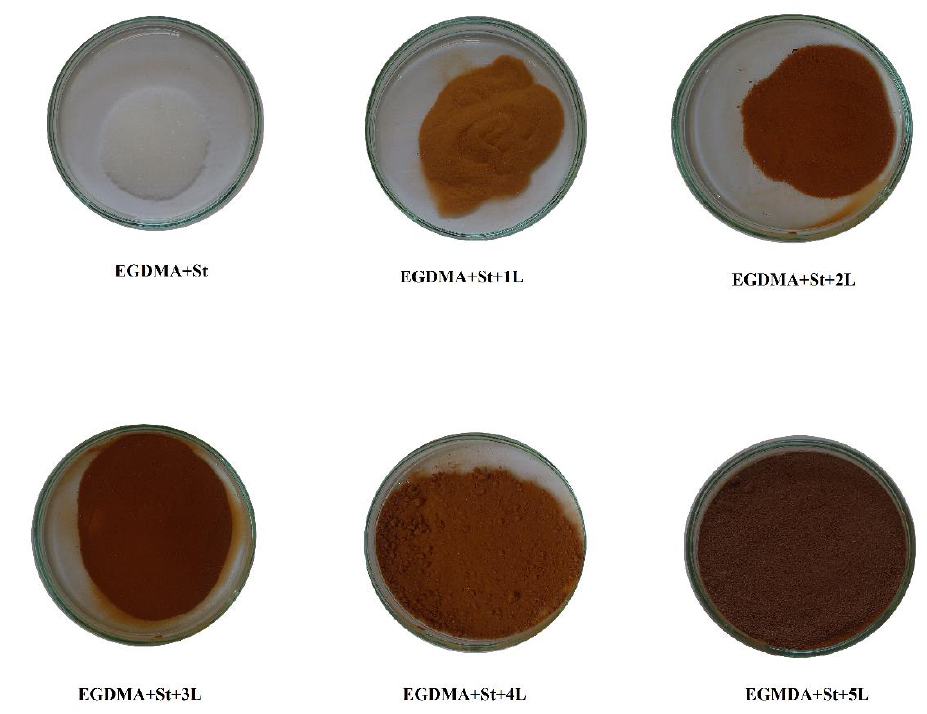
Figure 3. Photos of the obtained microspheres EGDMA-St with different amounts of lignin (1–5 g).